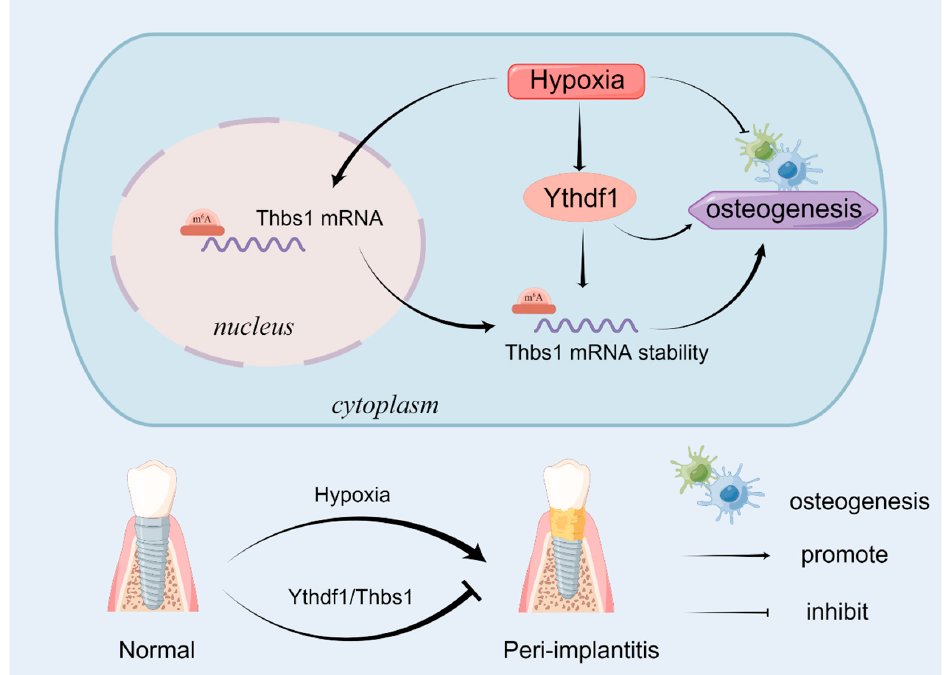
Figure 6. The role of the RNA-binding protein of N6-methyladenosine methylation YTHDF1 in a hypoxia-induced MC3T3-E1 cell model of osteoblasts. Hypoxia inhibited osteogenic differentiation and promoted the expression of YTHDF1 and THBS1, and the depletion of either YTHDF1 or THBS1 exacerbated the osteogenic inhibition caused by hypoxia, respectively. The increased expression of YTHDF1 under hypoxia enhanced the translation of THBS1 under hypoxia by stabilizing the mRNA transcript of THBS1. Inflammation-induced hypoxia aggravates bone resorption in peri-implantitis, while hypoxia-activated YTHDF1 with THBS1 promotes osteogenesis to prevent bone resorption. YTHDF1, Yth m 6 A RNA-binding protein 1; THBS1,